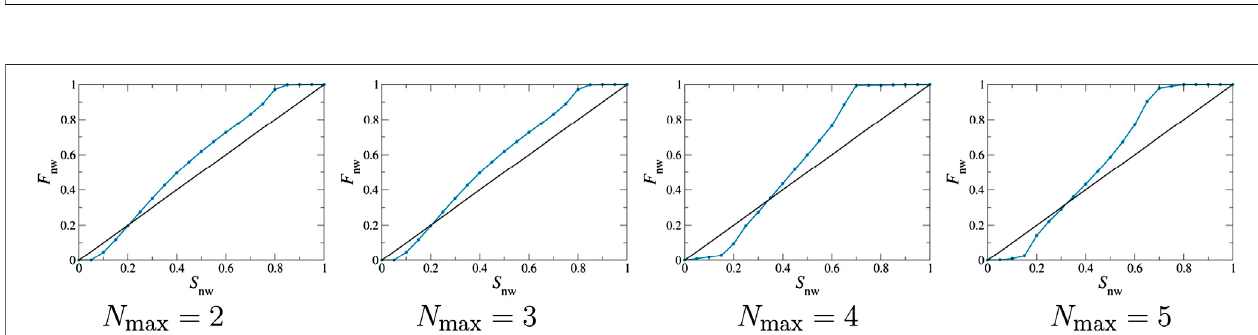
FIGURE 6 | Steady-state fractional fl ow at fi nite capillary numbers Ca (cid:1) 0 . 1 and 0.01 with the merging rules B : merge_cm (top row) and C : merge_cmnn (bottom row). The left and right plots for each capillary number correspond to N max (cid:1) 2 and 3 respectively. With B , F n approaches toward the diagonal line at higher saturation S n > 0 . 8 for the fi rst three plots.